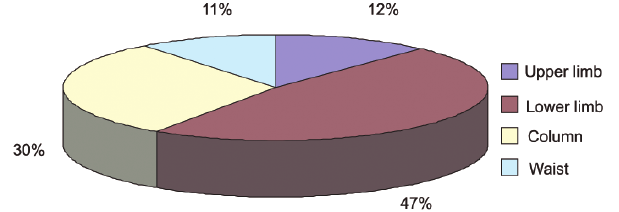
Figure 3 - Distribution according to fracture site per segment